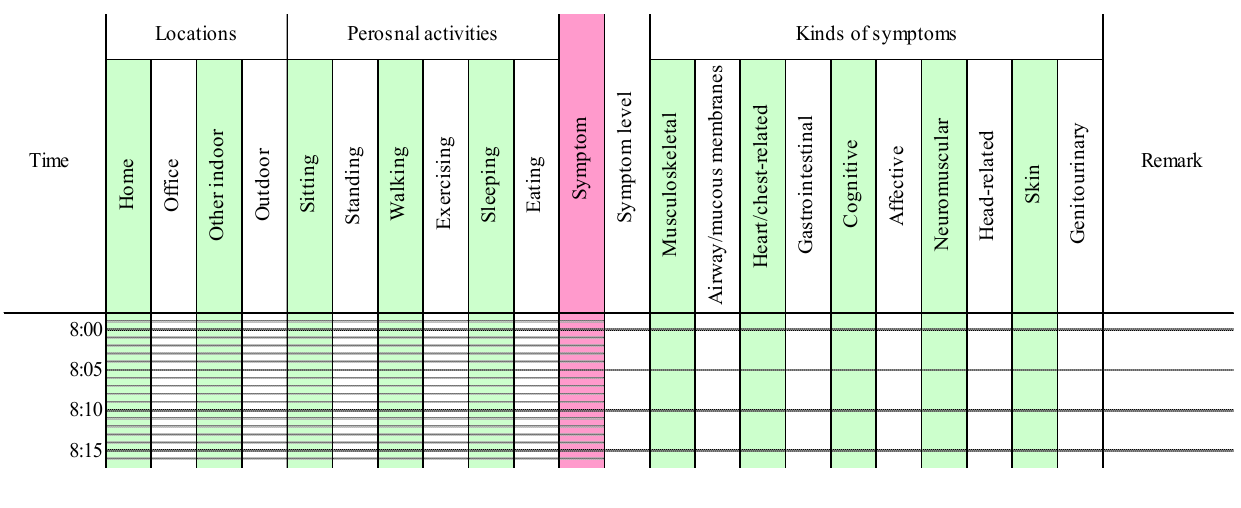
Figure 1. An example of a time-activity log